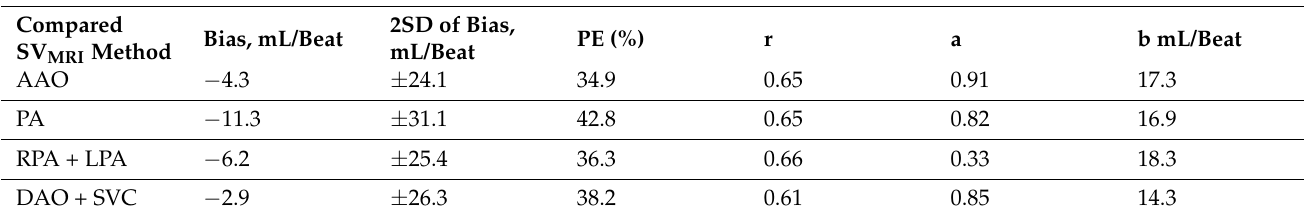
Bland and Altman Analysis